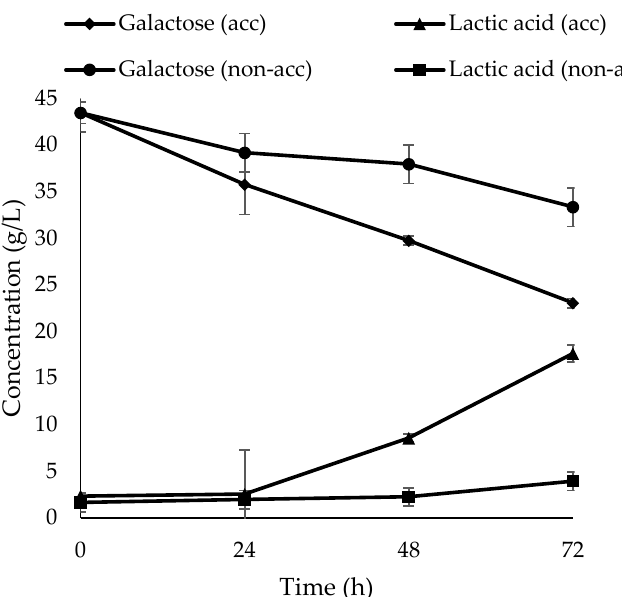
Figure 2. Batch fermentation kinetics of lactic acid by acclimatized (acc) and non-acclimatized (non-acc) cultures of Lactobacillus pentosus from Kappaphycus alvarezii hydrolysates in conical flask with 20 g/L CaCO 3 buffer, using a 1.2 g/L inoculum, at 37 °C, and 150 rpm. Table 4. Fermentability of K. alvarezii hydrolysates by acclimatized L. pentosus for lactic acid produc- tion carried out in 100-mL serum flasks with a 70 mL working volume of hydrolysate media with a 72-h incubation period. Table 5. Batch 72-h fermentation kinetics of lactic acid by acclimatized and non-acclimatized cul- tures of Lactobacillus pentosus , from detoxified Kappaphycus alvarezii hydrolysates in conical flask with 20 g/L CaCO 3 buffer, using a 1.2 g/L inoculum, at 37 °C, and 150 rpm.